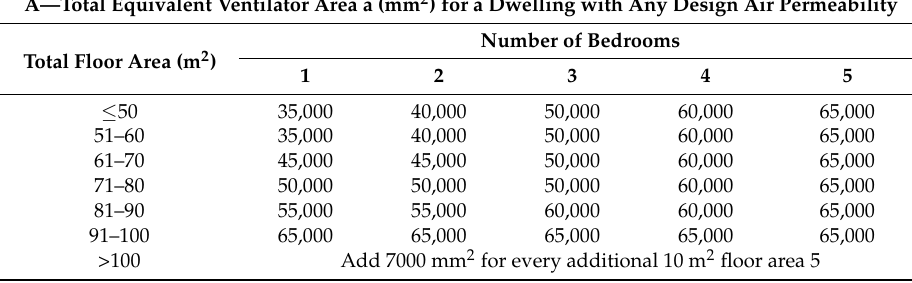
Table 5. Total equivalent ventilator area of Trickle Vents for dwellings [40].